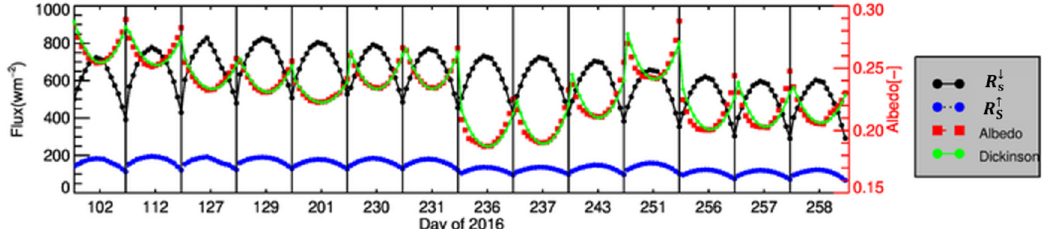
Figure 3. The diurnal cycle of incoming (black dots), outgoing shortwave radiance (blue dots) and the surface albedo (red dots) during daytimes (09:30 to 16:30 LT) at the Veenkampen site, for the 14 selected clear days during 2016.